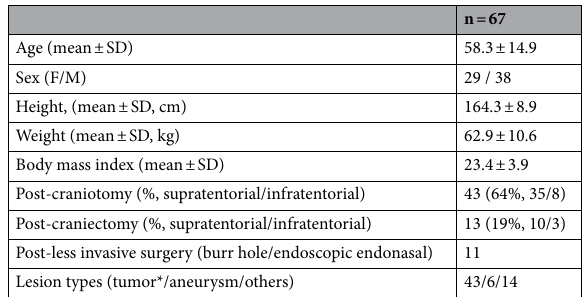
Table 1. Baseline patient characteristics. SD standard deviation. *Meningiomas, n = 20; gliomas, n = 9; pituitary tumors, n = 6; schwannomas, n = 4; and other types, n =